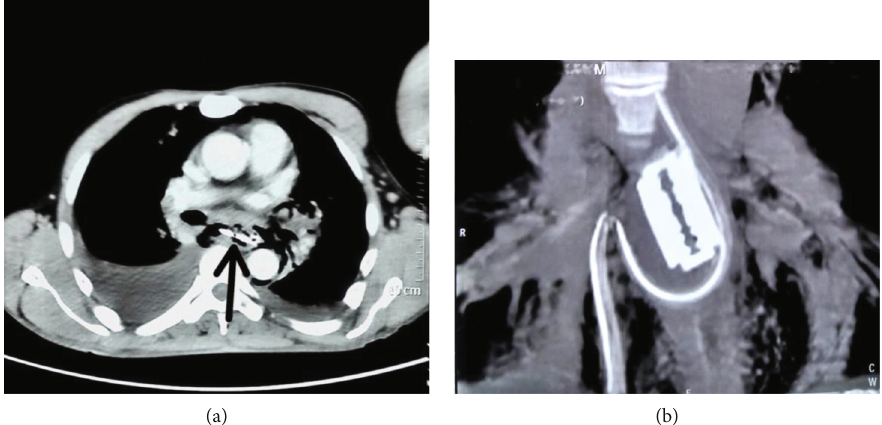
Figure 1: CT chest. (a) Sharp razor blade (arrow) in the mediastinum with pneumomediastinum and moderately large right pleural e ff usion. (b) Reconstructed image shows the whole blade; apparently, the NG tube traveled through the mediastinum.